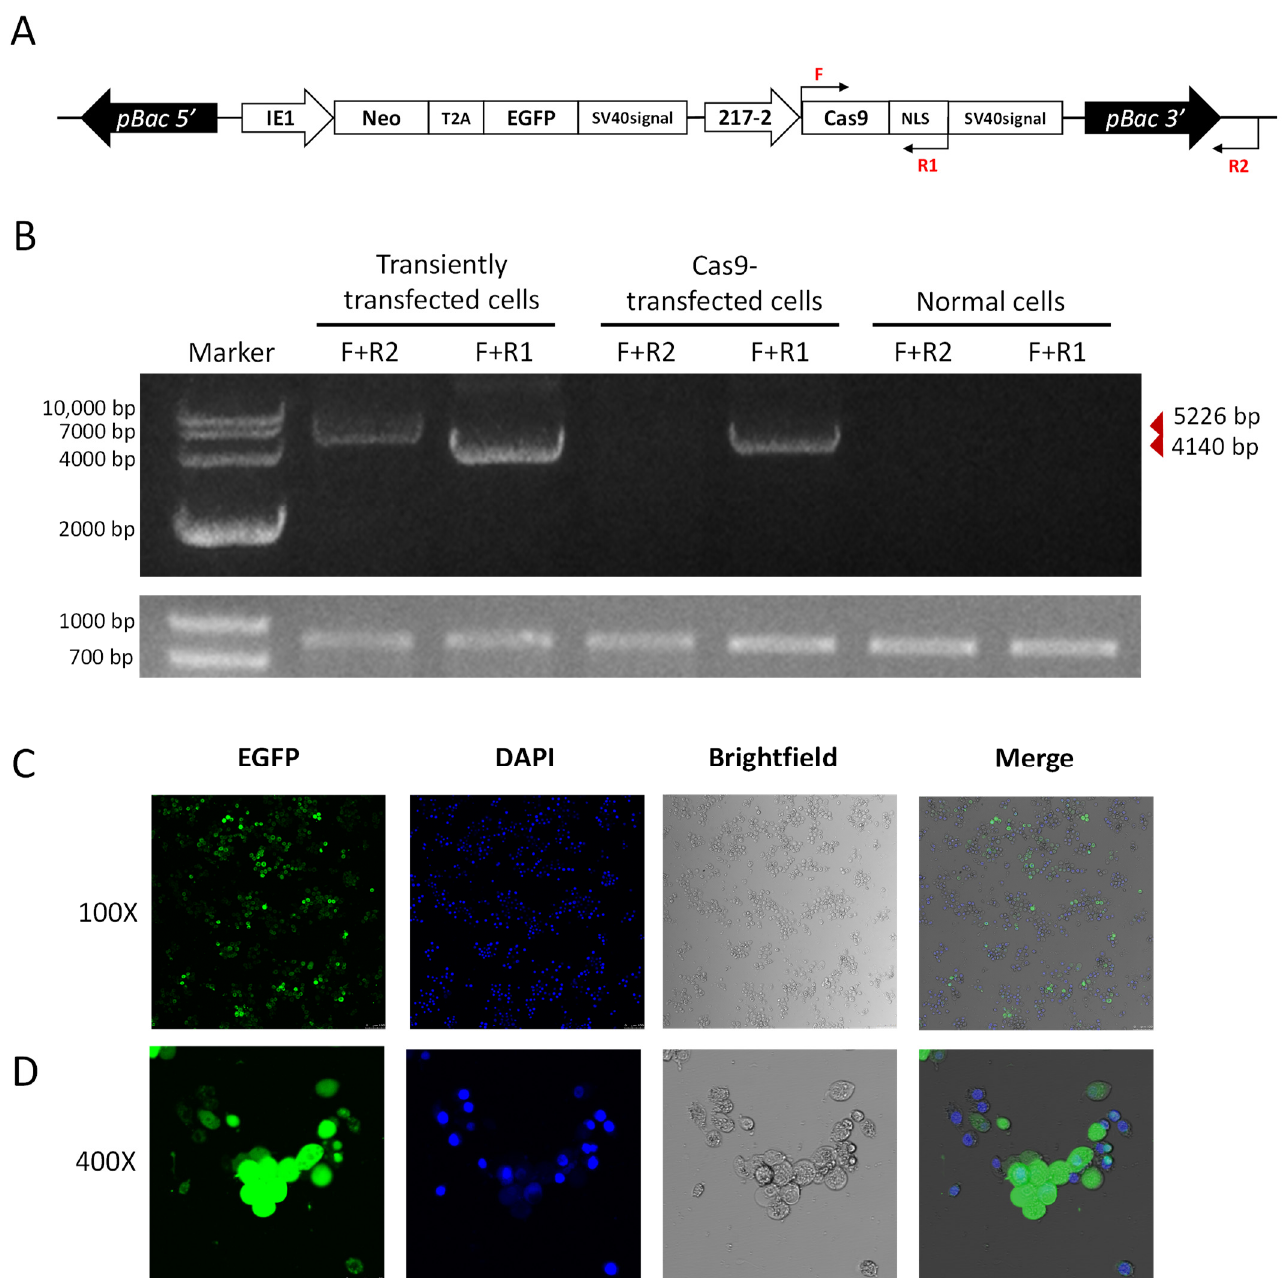
Figure 6. The transgenic Cas9 cell lines of P. xylostella . ( A ) The position of the primers for detection in the transgenic Cas9 cells. The amplification direction of F, R and R1 is consistent with the directions of the respective arrows. ( B ) The amplification results of detection primers for transgenic Cas9 and non-transgenic cells. The gel image below is the amplification result of 830 bp in the Pxubx gene sequence. ( C , D ) Fluorescence images at 100× and 400× after incubation of transgenic Cas9 cells with DAPI staining solution. Photographed by laser confocal, exposure time and excitation light intensity are consistent during shooting.